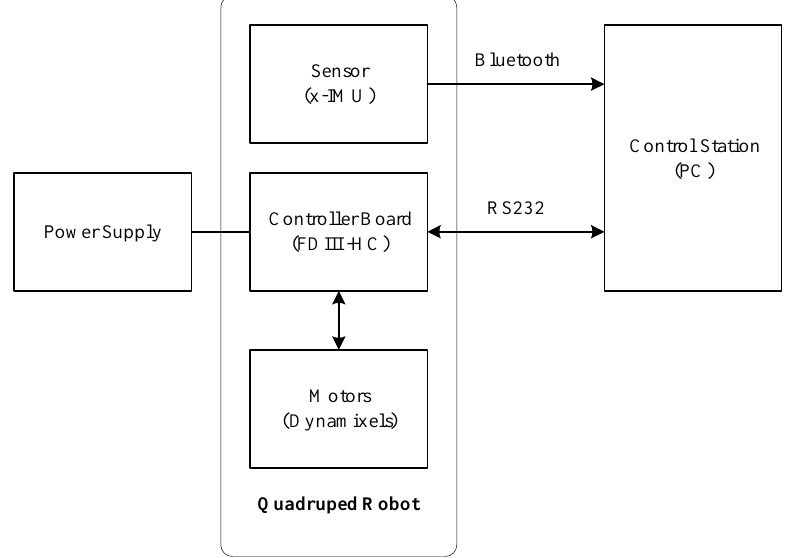
Figure 4. Block diagram of robotic